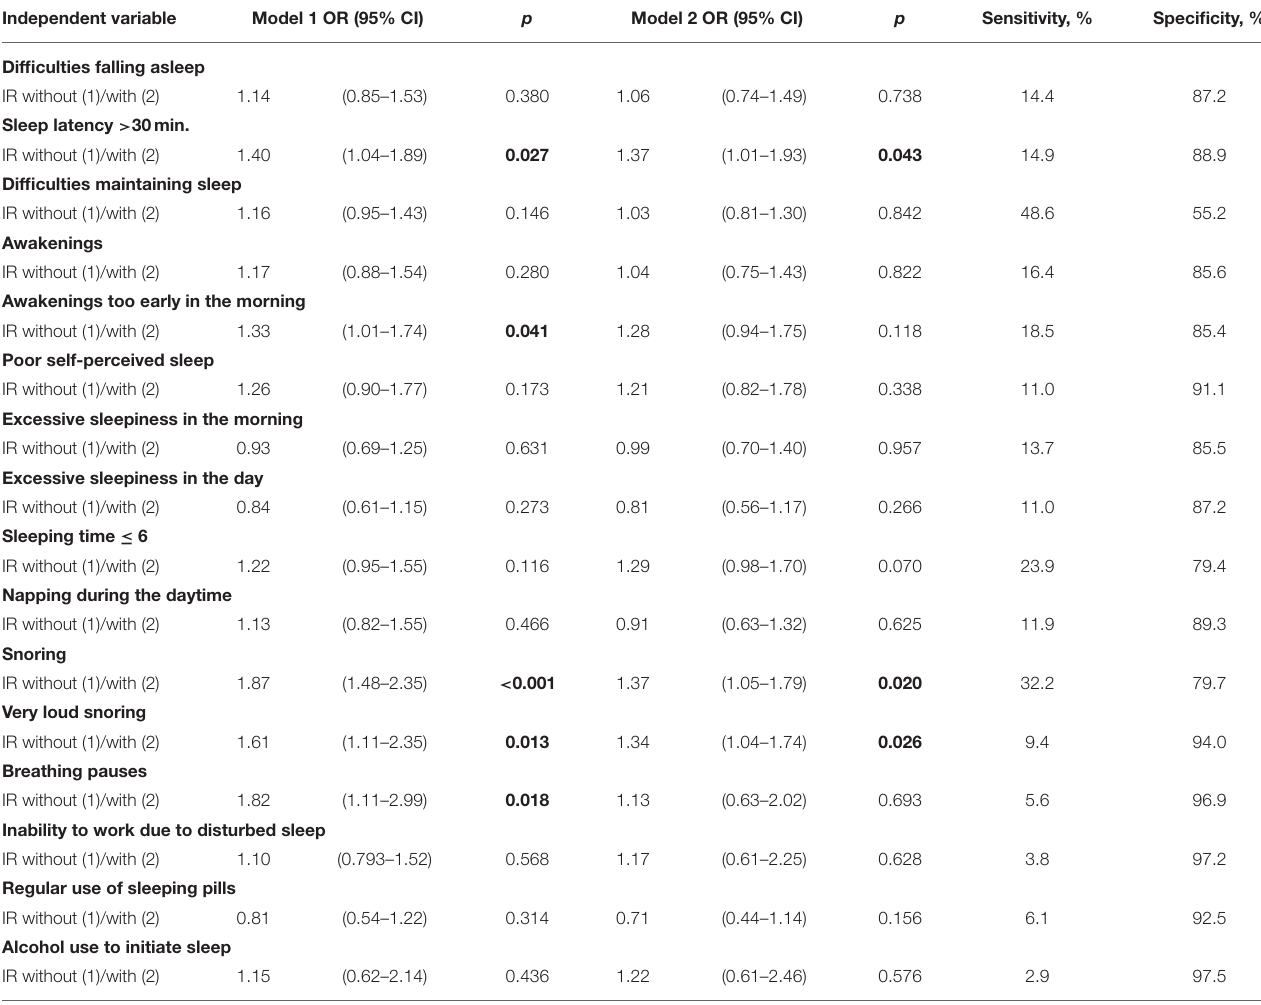
TABLE 3 | Logistic regression between insulin resistance and sleep complaints. Independent variable Sensitivity, % Specificity,